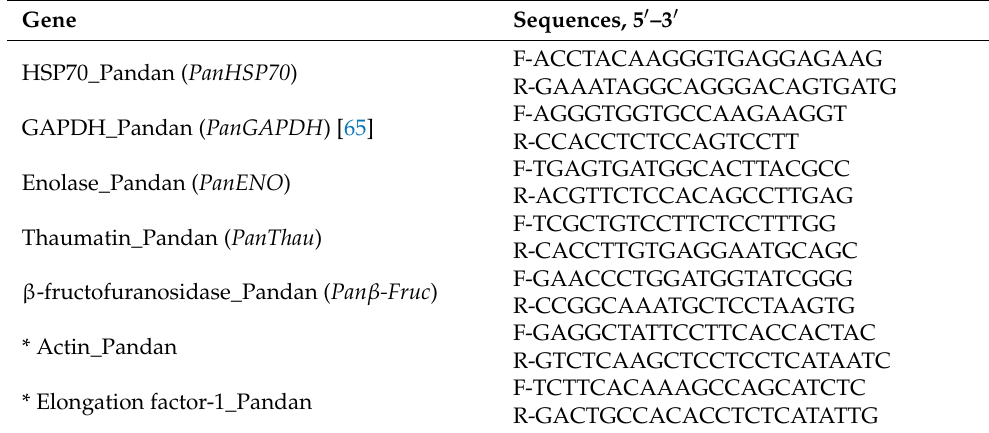
Table 2. List of genes and their primer sequences used for relative expression analysis.